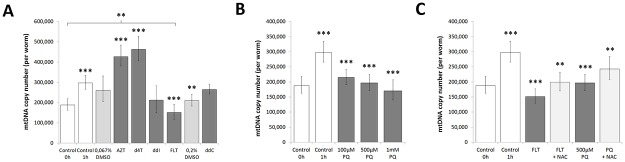
A: mtDNA copy number was altered upon short term (1h) exposure to NRTIs and B: paraquat. A: 200μM NRTIs and B: paraquat induced changes in mtDNA copy number compared to their respective controls after 1h exposure: 0.067% DMSO for AZT, d4T, ddI & FLT; 0.2% DMSO for ddC; and control for paraquat. mtDNA copy number increases during nematode development and therefore rose after 1h (control 0h vs control 1h). FLT & paraquat inhibited normal mtDNA copy number increase. AZT & d4T exposure resulted in higher mtDNA copy numbers. 0.2% DMSO reduced mtDNA copy number. Error bars show the 95% C.I. (51df) from ≥3 replicates per 2 individual experiments. NRTIs and paraquat were compared to control animals at 1h. C: mtDNA copy number decrease by FLT and paraquat was attenuated by NAC. 200μM FLT and 500μM paraquat decreased mtDNA copy number compared to control nematodes after 1h exposure (dark grey vs 1h control). Supplementation of an anti-oxidant (NAC) attenuated this decline (light grey vs dark grey). Anti-oxidant concentration = 100μM. Error bars show the 95% C.I. (51df) from ≥3 replicates per 2 individual experiments. Control animals at 1h compared to FLT and paraquat, and drugs + anti-oxidants compared to drugs only, and Control 1h vs Control 0h. Significance was determined using a two-tailed student’s t-test assuming unequal variance. * = P-value <0.05, ** = P-value <0.01, *** = P-value <0.001.